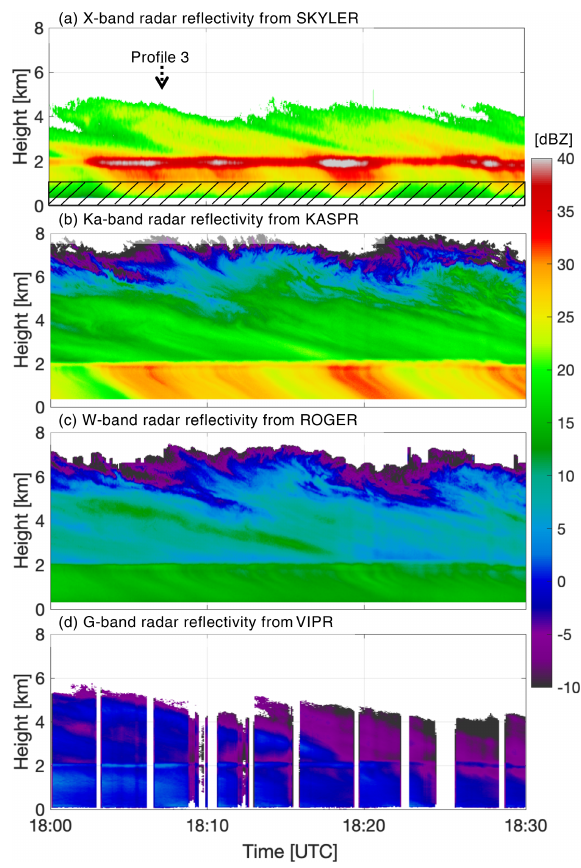
Figure 8. Time–height of radar reflectivity measured by (a) SKYLER, (b) KASPR, (c) ROGER and (d) VIPR between 18:00 and 18:30UTC on 25 February 2020. Observations covered by the hatching in panel (a) are known to be biased low because of a human error in setting the radar receiver blanking parameters. The arrow in panel (a) points to the time of the profile displayed in Fig.